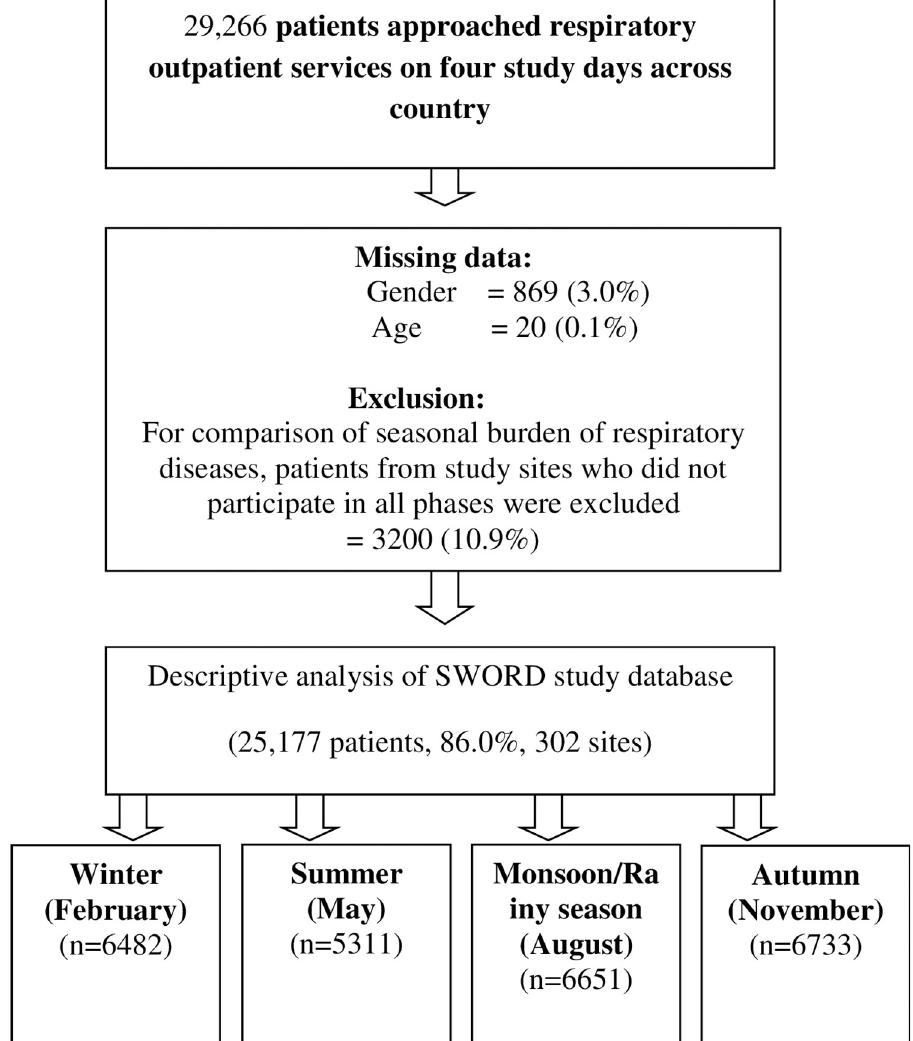
Fig 1. Flow diagram. A total of 302 sites across the country were included for assessment of seasonal patterns in the SWORD survey. The flow diagram shows the selection of sites and division of study population according to seasonal